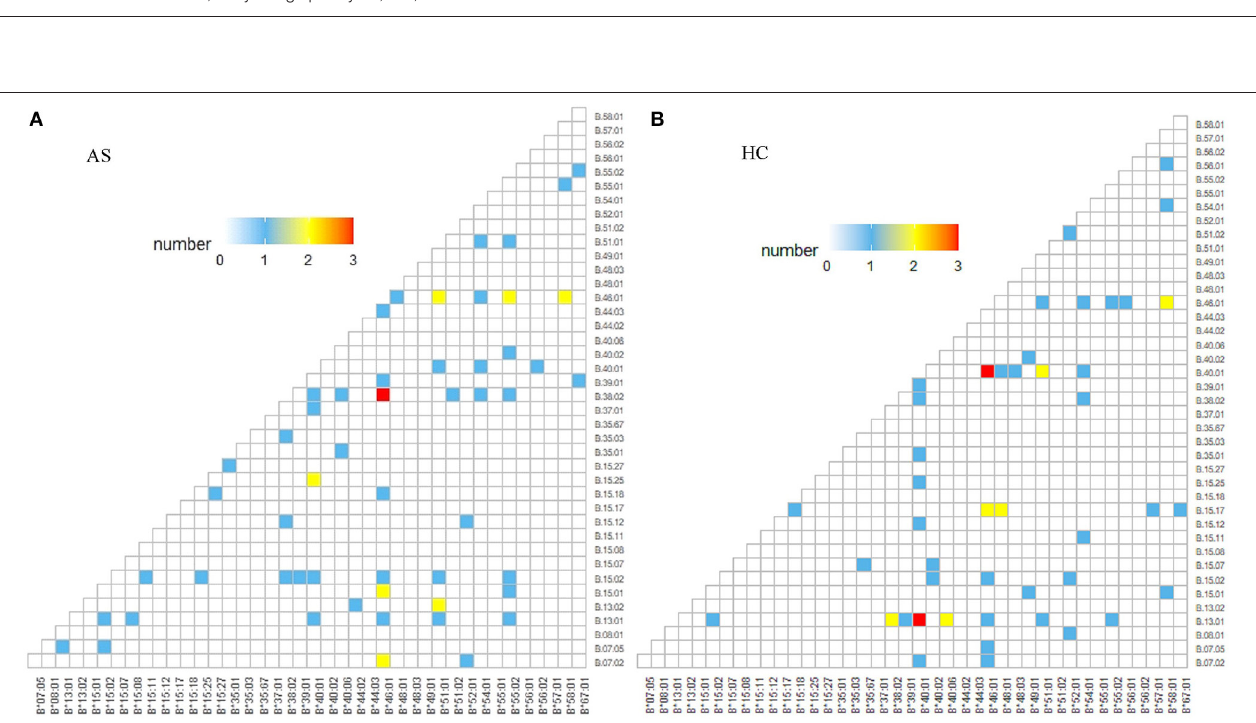
FIGURE 3 | HLA-B alleles heatmap of different HLA-B27 subtypes combined with other HLA-B subtypes. Each square represents a genotype, like HLA-B*27:04/B*40:01. AS, ankylosing spondylitis; HC, health control.